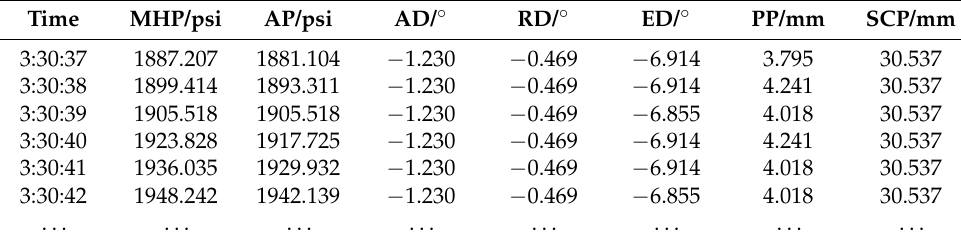
Table 3. Statistics of the main hydraulic pressure.